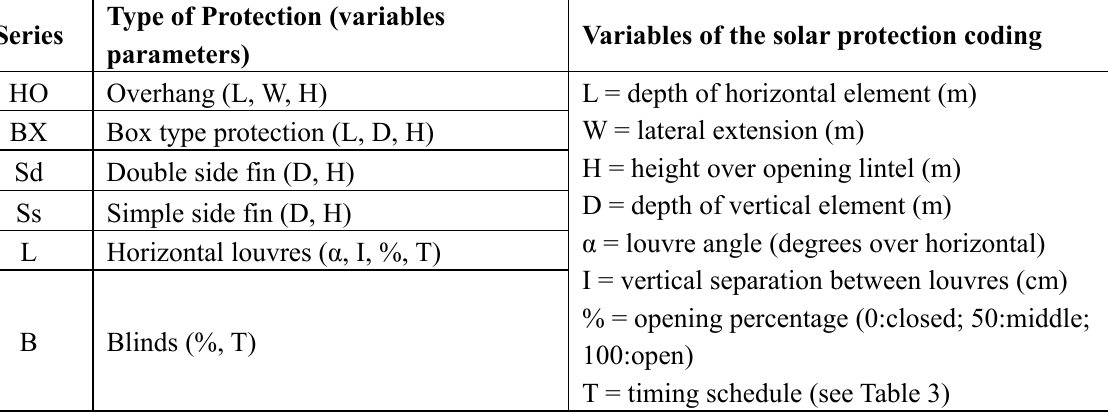
Table 2. Series of solar protectors